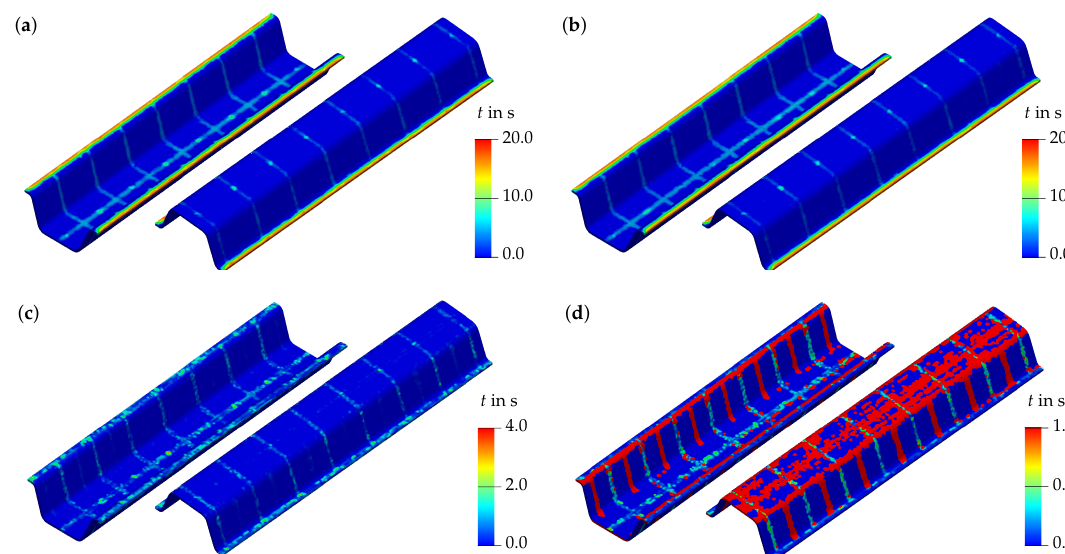
Figure 13. Comparison of t m for sample 52. ( a ) Numerical result of full-scale simulation; ( b ) predicted result by Random Forest; ( c ) absolute difference; ( d ) relative error (values with error > 1 are indicated by the color